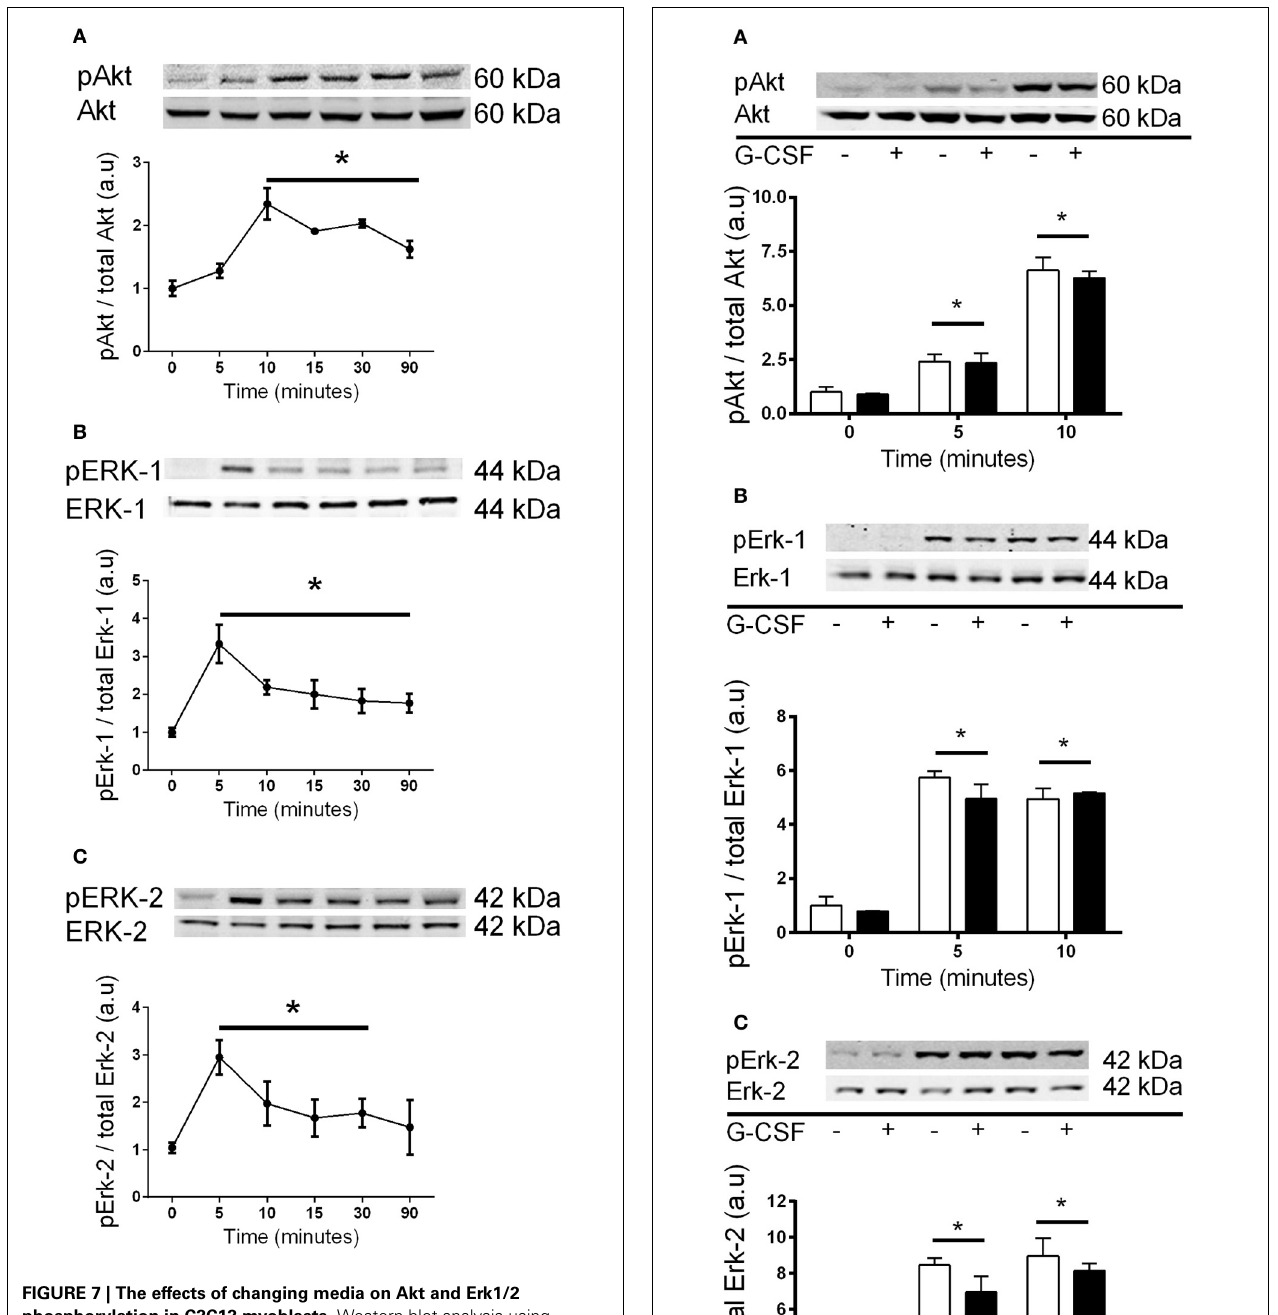
FIGURE 8 | Akt and Erk1/2 phosphorylation with 40ng/ml G-CSF vs. vehicle treatment in myoblasts. Fold changes in phosphorylation for (A) Akt (B) Erk-1, and (C) Erk-2 after treatment with fresh media containing 40ng/ml G-CSF (black bars) or vehicle control (white bars). Data is shown as mean ± SEM compared to time zero ( n = 3, ∗ p < 0 .